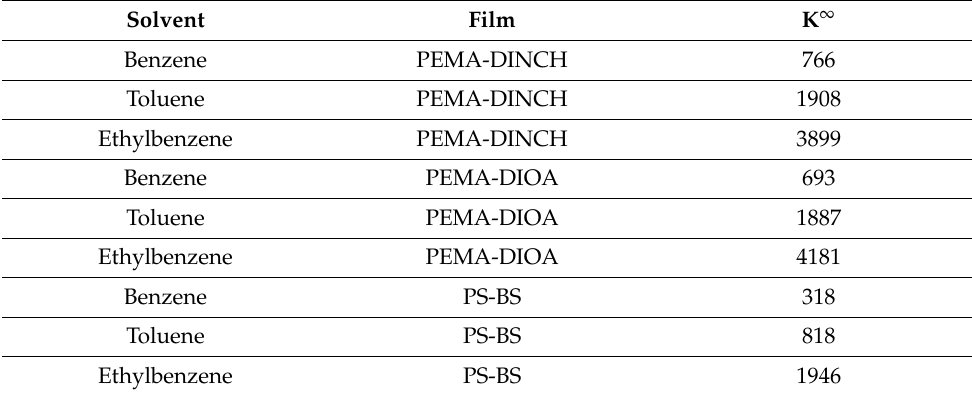
Table 4. Values of infinite dilution partition coefficients (K ∞ ) for benzene, toluene, and ethylbenzene in plasticized PEMA and PS films [25].